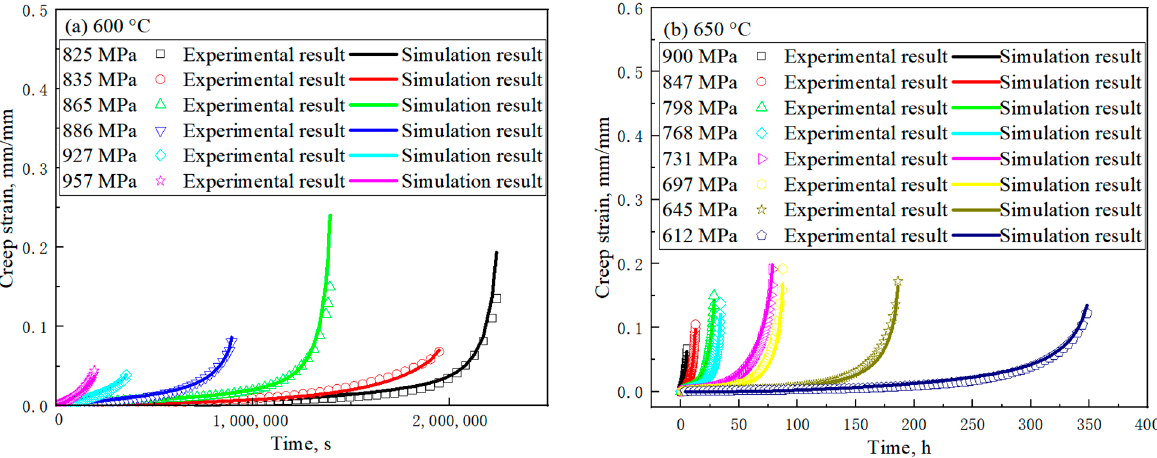
Figure 14. Simulation results of creep tests at different temperatures: ( a ) at 600 °C; ( b ) at 650 °C. Table 2. The parameters of creep model at 600 °C.